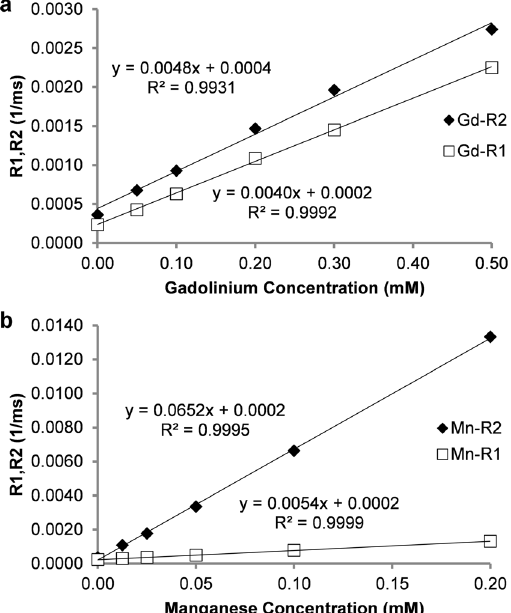
Figure 1. Relaxivity assessments for ( a ) gadolinium (Gd) and ( b ) manganese (Mn) contrast agents from a 60 MHz relaxometer using phantoms containing varying concentrations of a single contrast agent. Slopes of the fitted lines of R1, R2 vs. agent concentration (n = 6 for each agent) were used to determine the relaxivities (r 1 and r 2 ) of the two agents. Pearson correlations resulted in significant correlations of concentration vs. R1 and R2 for both contrast agents (R 2 > 0.993, two-tailed probability p < 0.0001).